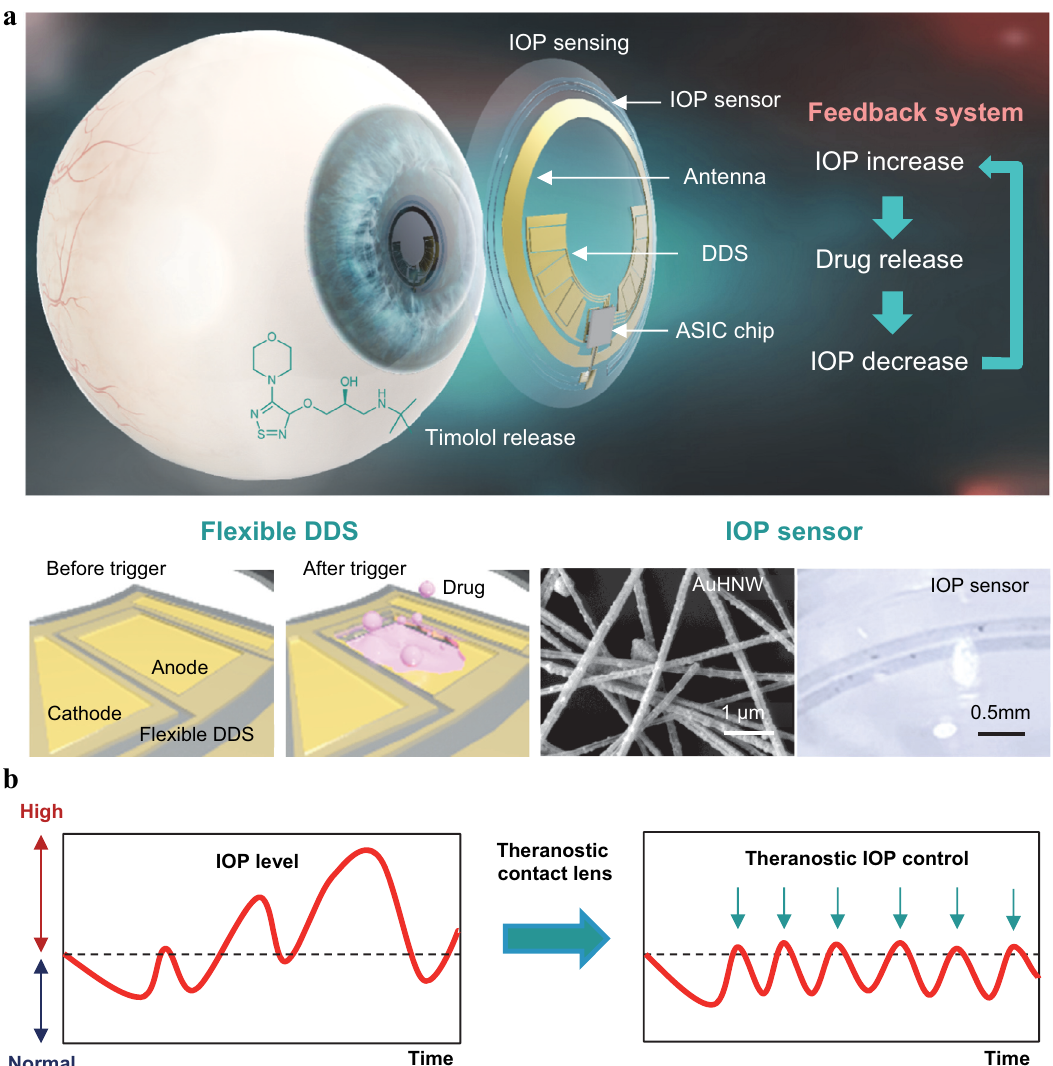
Fig. 1 | Schematicillustrationofa theranosticsmart contact lens forglaucoma treatment.a Thestructureoftheranosticsmartcontactlenswithafullyintegrated AuHNW-based IOP senor, a DDS, and wireless circuits for wireless glaucoma